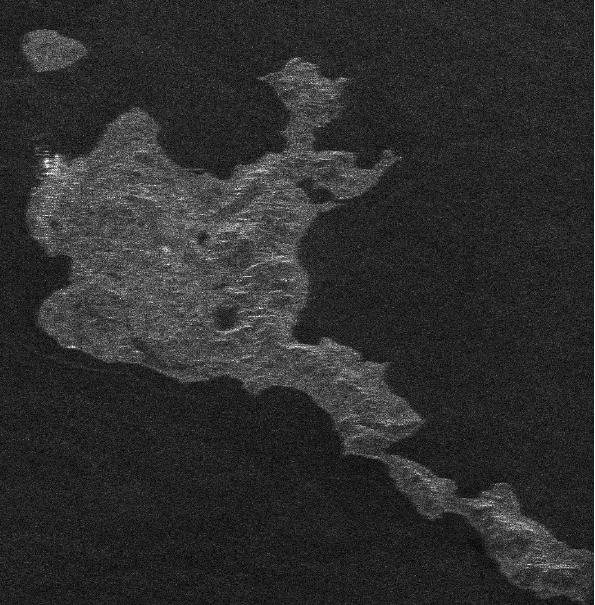
Figure 18. The result of using the BURG extrapolation algorithm when the Sentinel-1 azimuth periodically missing data (vertical range, horizontal azimuth).